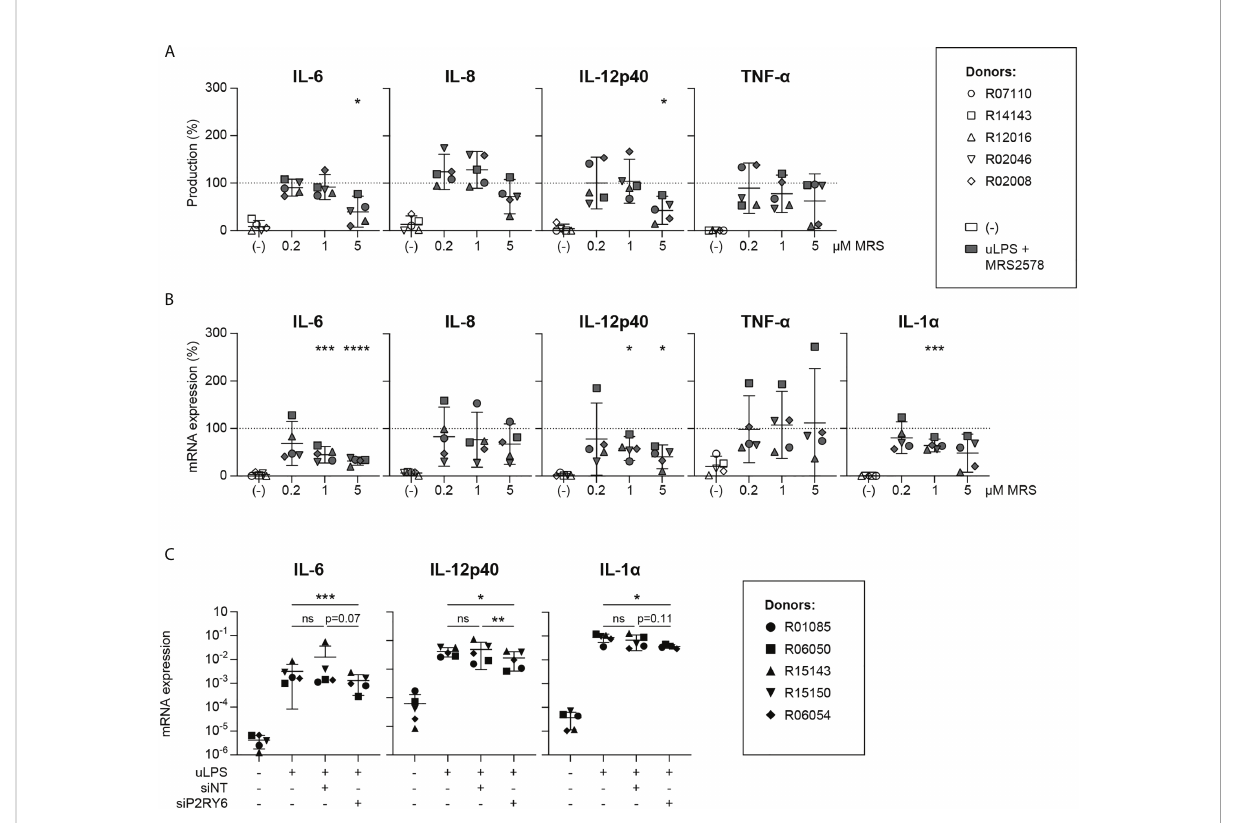
FIGURE 2 uLPS-induced IL-6, IL-12p40 and IL-1 a expression levels are dependent on P2RY6-mediated signaling. Primary microglia from rhesus macaques were exposed for 16 h to 10 µg/mL uLPS (TLR4) with or without 1 h pre-incubation of 0.2, 1 or 5 µM P2RY6 antagonist MRS2578. The effects of P2RY6 antagonist on uLPS-induced IL-6, IL-8, IL-12p40, TNF- a and IL-1 a were analyzed. Graphs show the effects of P2RY6-mediated signaling on TLR4-induced (A) cytokine production and (B) mRNA expression levels. Levels of all graphs are expressed relative to levels after exposure to uLPS alone (dotted line =100%). Symbols represent different donors. Horizontal lines indicate mean values with 95% con fi dence intervals. n=5, paired t-test on log-transformed data, *p < 0.05, ***p < 0.005, ****p < 0.001. (C) Effects of P2RY6 knockdown (siP2RY6) on uLPS-induced IL-6, IL-12p40 and IL-1 a mRNA expression levels. siNT = transfection with non-targeting control siRNA. Symbols represent different donors. n=5, one-way ANOVA on log-transformed data, ns, not statistically signi fi cant. *p < 0.05, **p < 0.01, ***p <